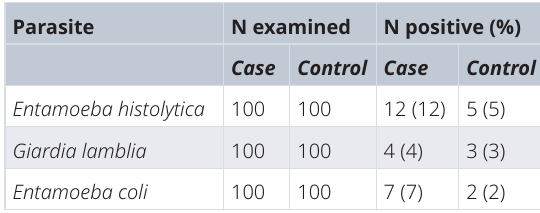
Table 3. Occurrence of different gastrointestinal parasites in H. pylori patients and control